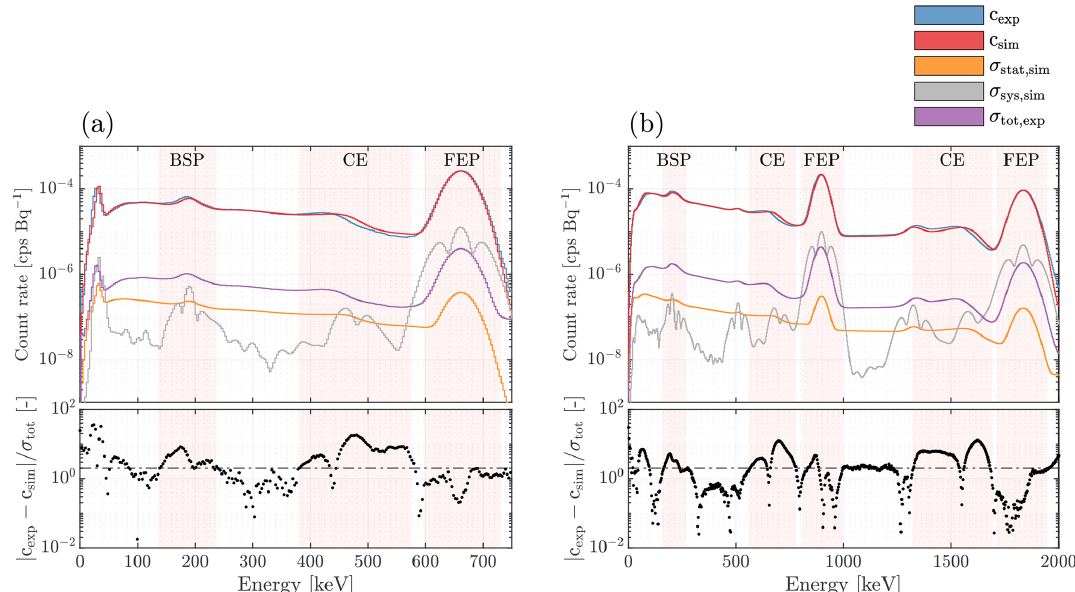
Figure A1. Uncertainty quantification of the spectral detector response for the summed scintillation crystal spectra. (a) 137 Cs radiation source. (b) 88 Y radiation source. The mean count rate spectra ( c exp , c sim ) together with the corresponding uncertainty estimates ( σ tot,exp